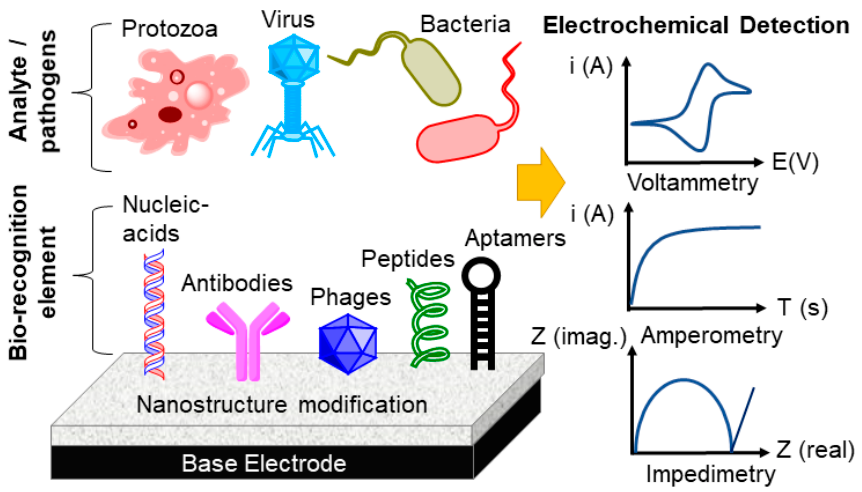
Figure 1. Schematic representation of the key components of a biosensor platform for the detection of foodborne pathogens.